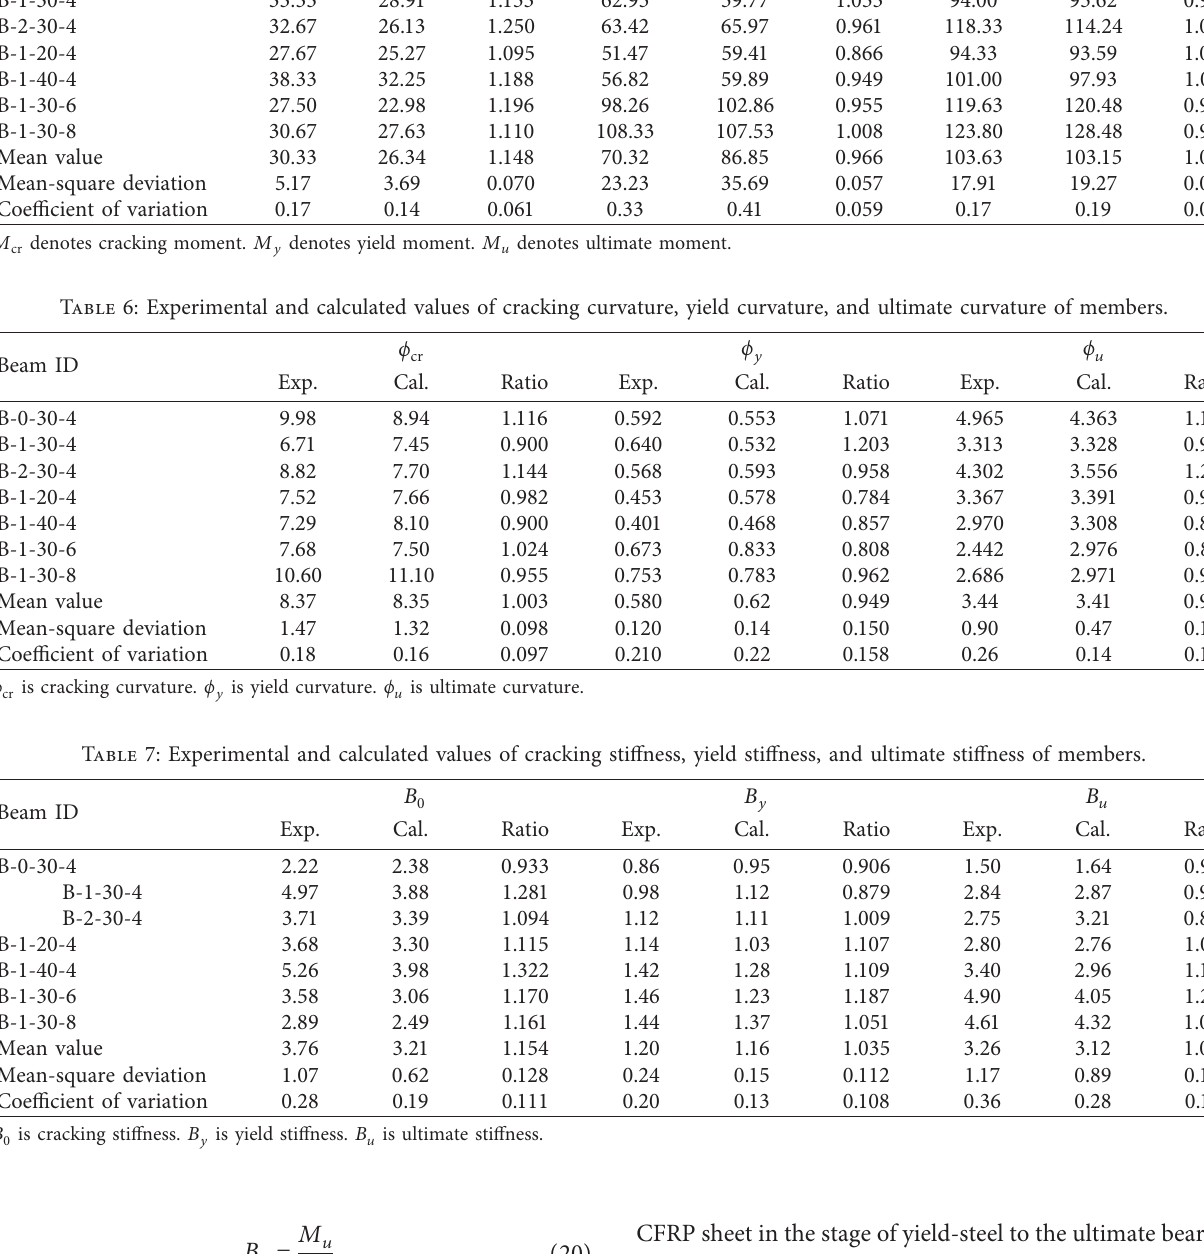
M cr Exp. Cal. Ratio Exp. Cal. Exp.